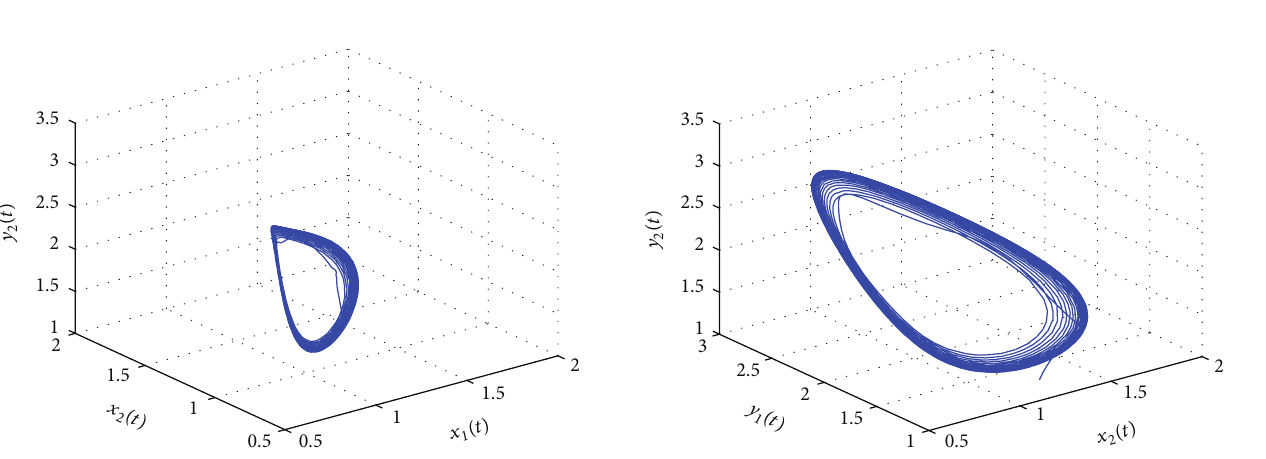
Figure 16: The track of the states 𝑥 1 , 𝑥 2 , 𝑦 1 , 𝑦 2 for 𝜏 = 3.2500 > 𝜏 0 = 3.1043 .